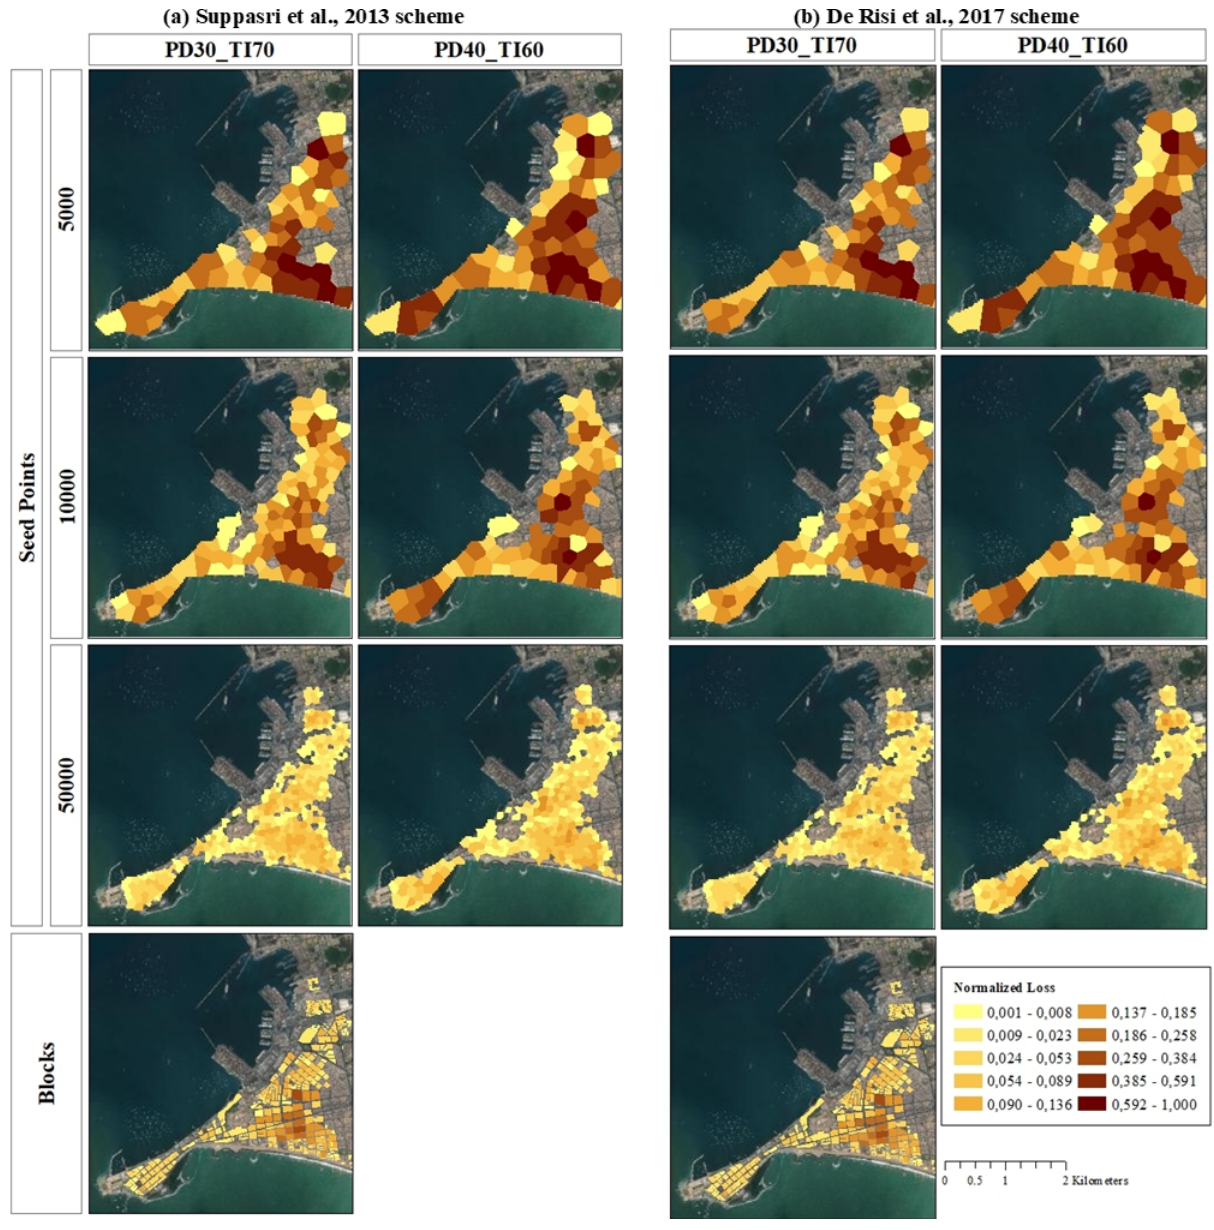
Figure 17. Spatial distribution of tsunami-induced normalised losses ( M w 8.8 scenario) for the La Punta sector (Callao district) using two tsunami reference schemes: (a) Suppasri et al. (2013) and (b) De Risi et al. (2017). Map data: © Google Earth